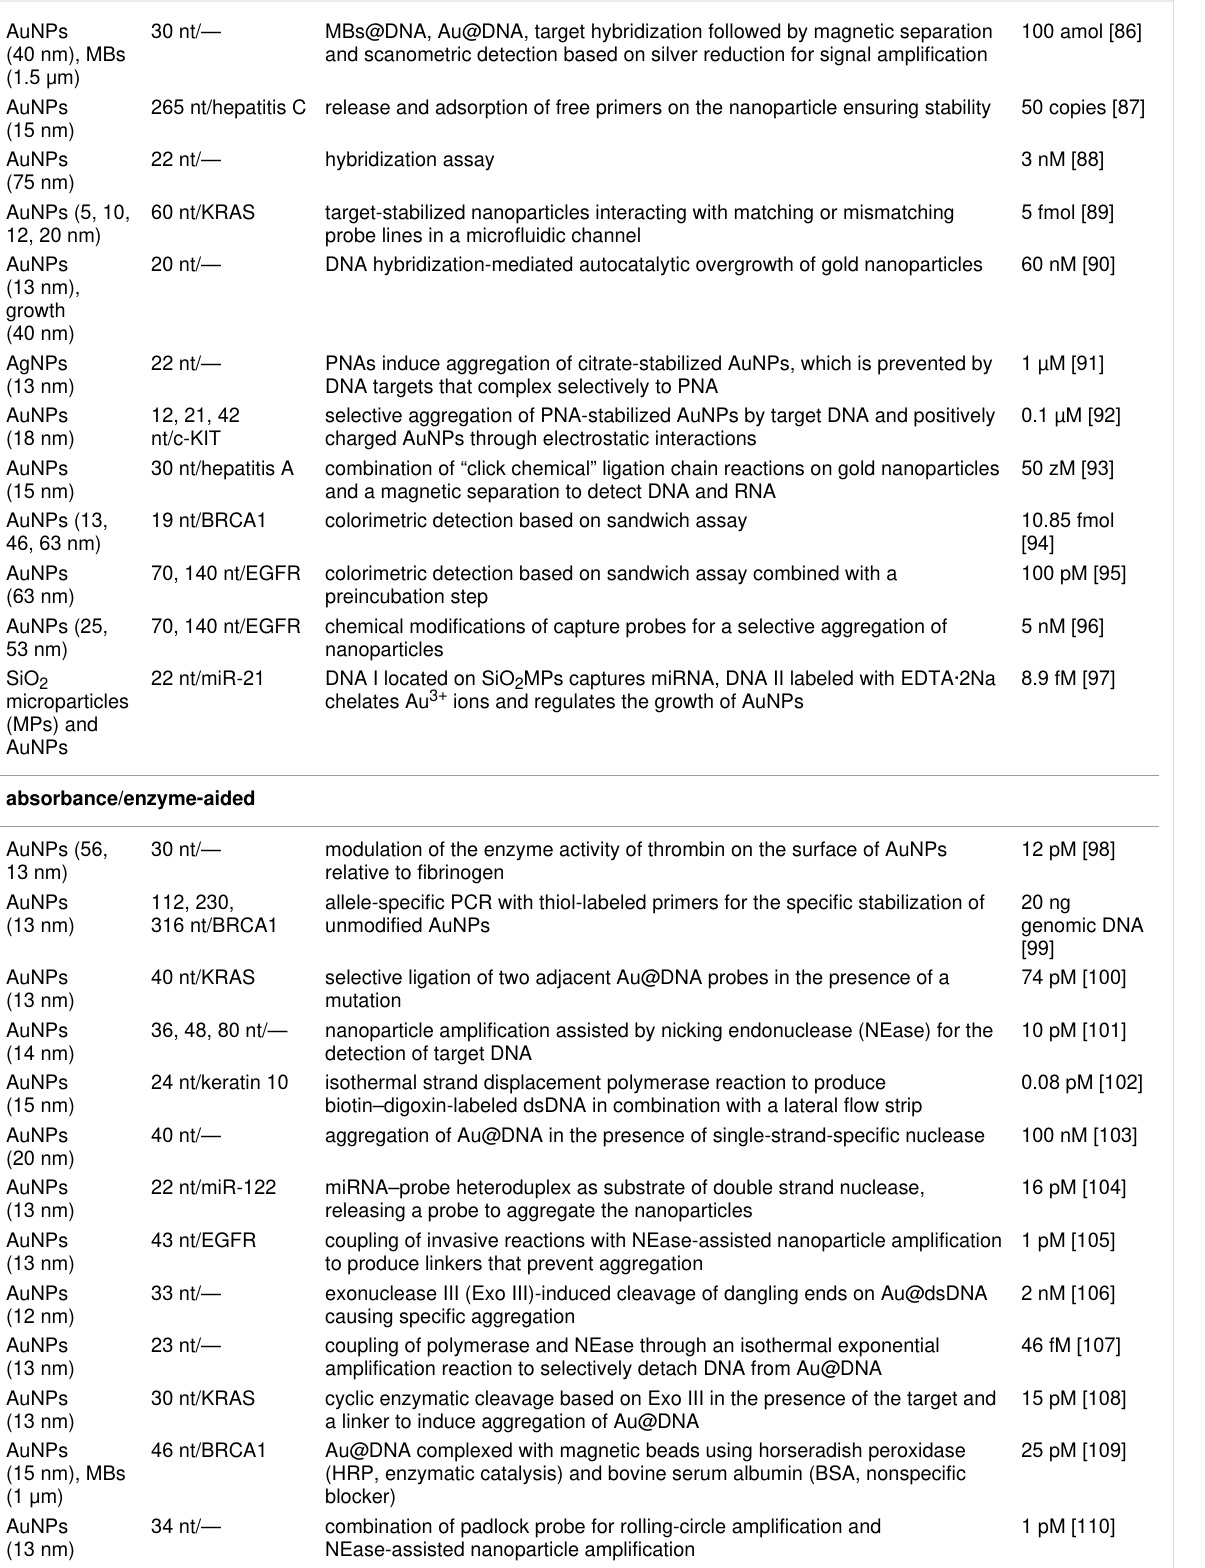
Table 3: Summary of particle-based optical assays for the detection of biomarkers. (continued) AuNPs 30 (40 nm), MBs (1.5 μ m)